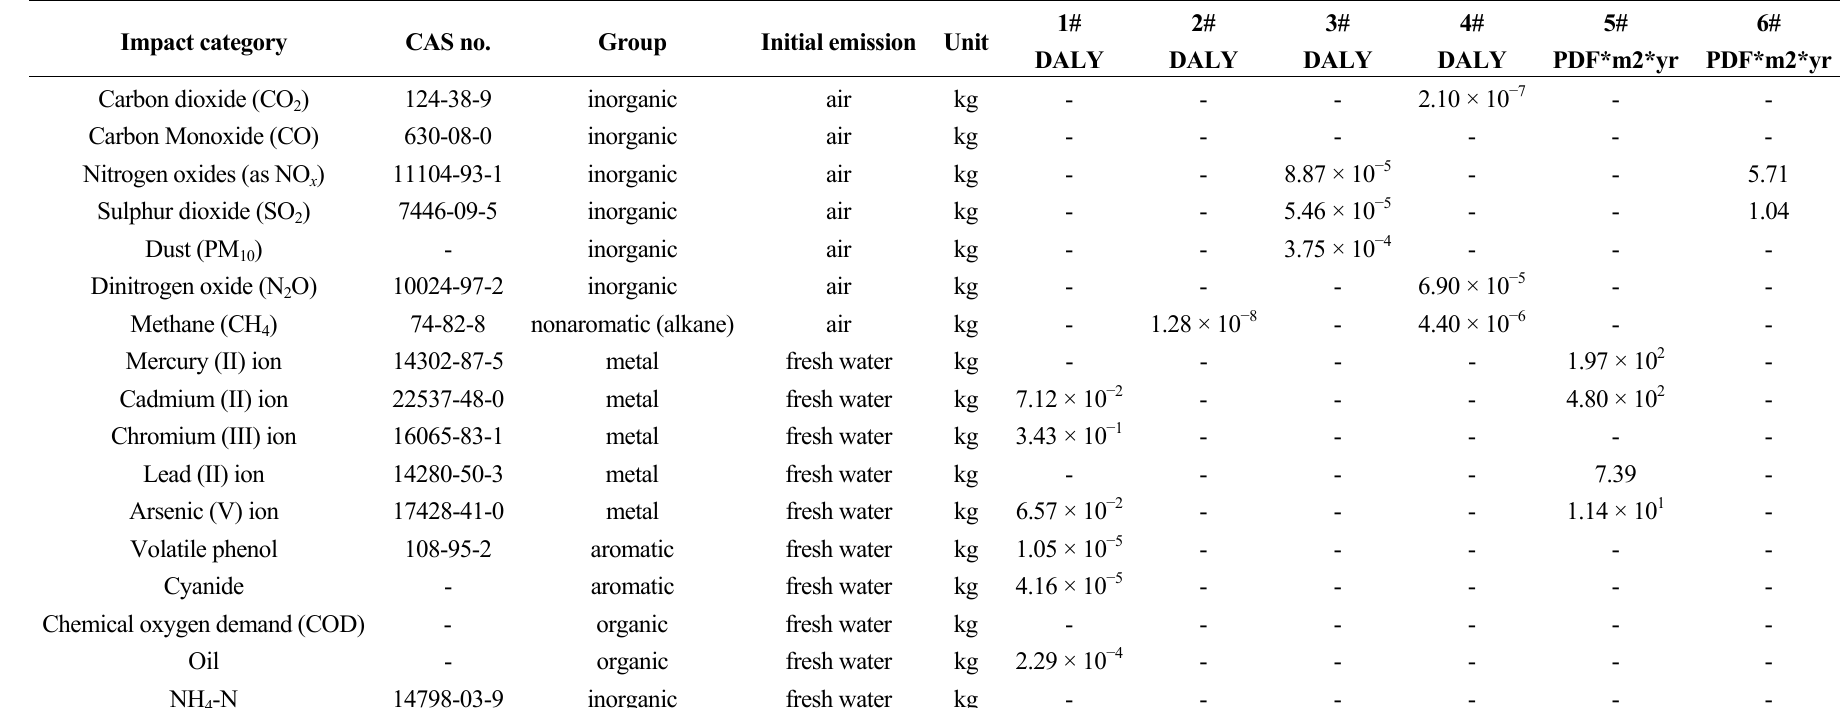
Table 1. List of emissions and environmental impacts based on a hierarchist